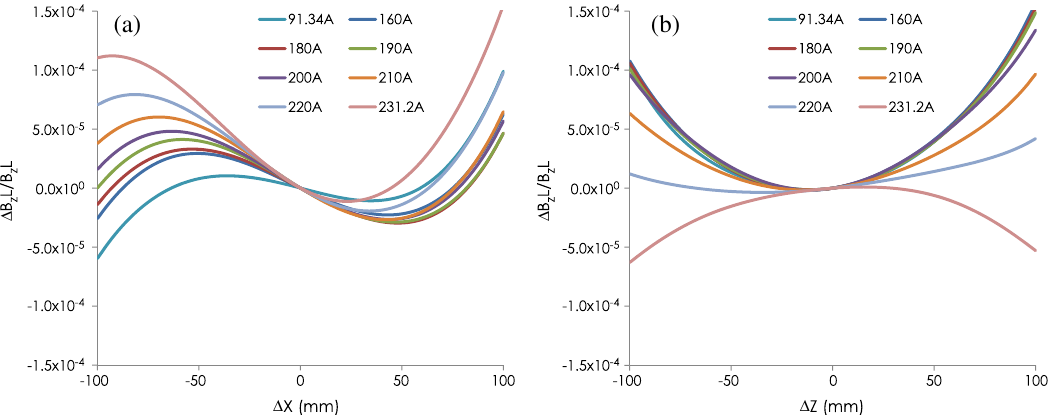
FIG. 17. Uniformity of BL products, (cid:1) B z L=B z L , of the dipole field for various coil currents of the dipole coil along (a) the X axis and (b) the Z axis, as determined by the three-dimensional field